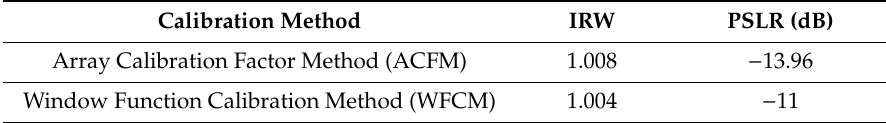
Table 1. The comparison of two calibration method performance.